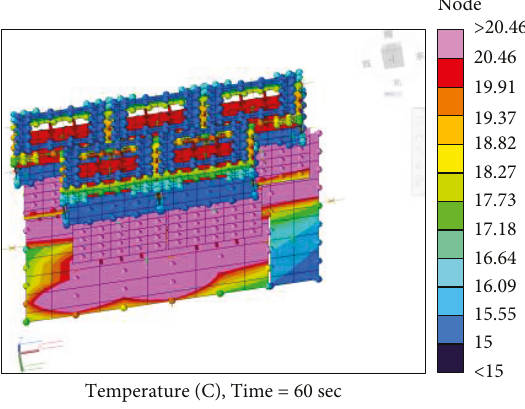
Figure 10: Temperature nephogram. Table 3: Statistical table of characteristic temperature.